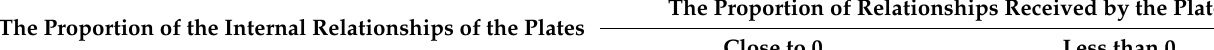
Table 4. Classification standards of the four major plates.